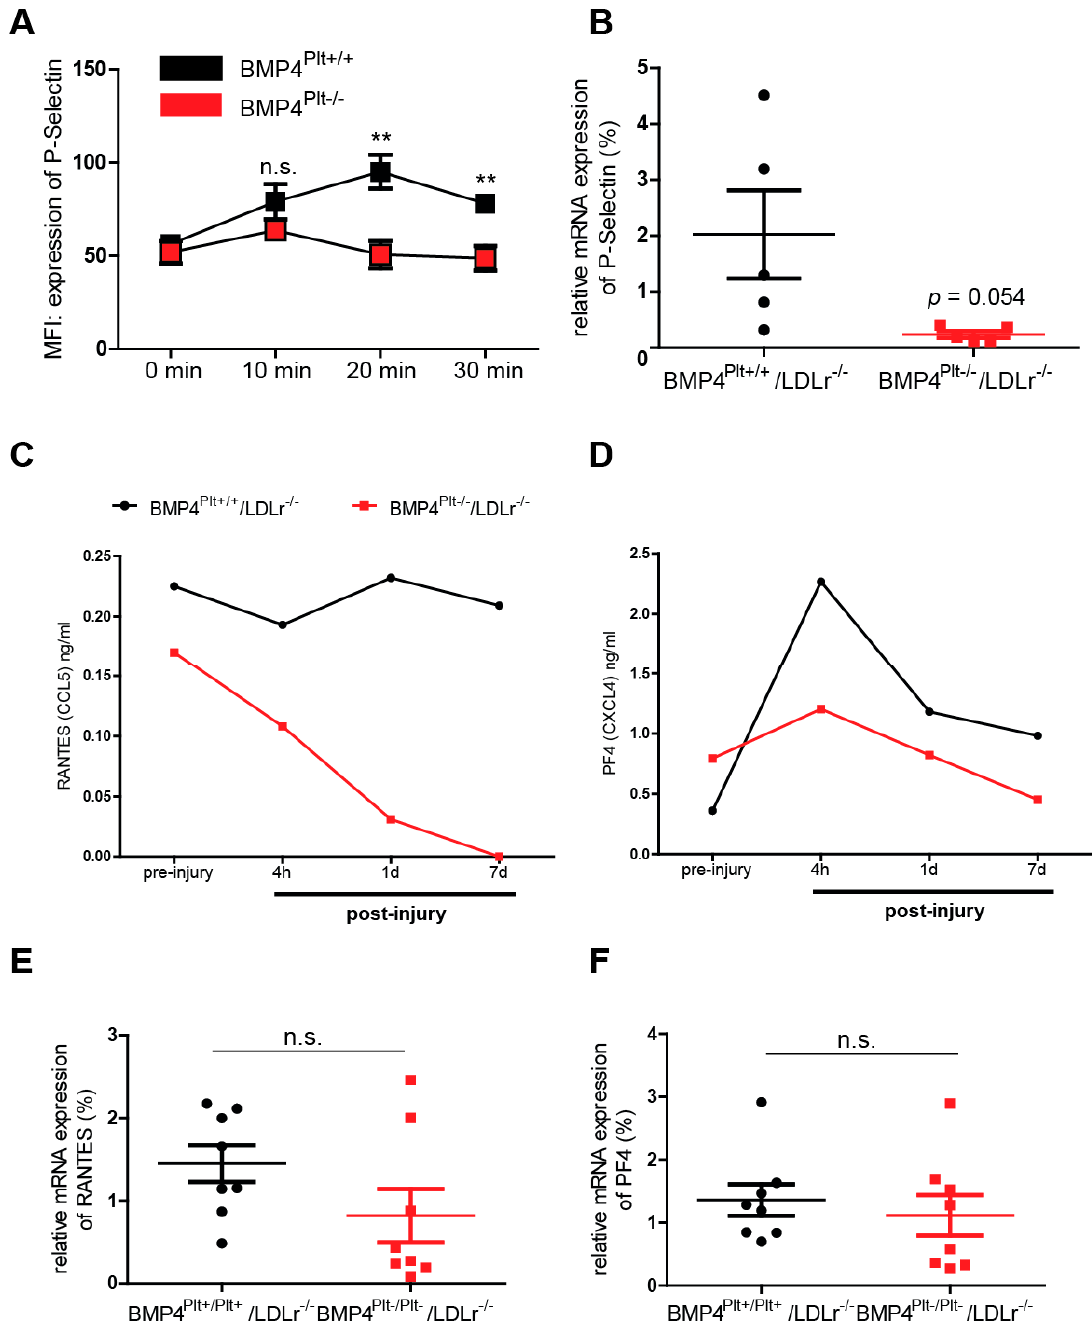
Figure 4. Platelet BMP-4 modulates expression and secretion of P-selectin, RANTES and PF-4. ( A ) Time-dependent release of P-selectin from platelets of control ( BMP4 Plt+/+ ) or BMP4 Plt − / − mice after treatment with TNF α (10 ng/g body weight). n = 5 per group. ( B ) mRNA expression of P-selectin in the carotid artery from control or BMP4 Plt − / − /LDLr − / − mice after guide wire injury. n = 5 per group. ( C , D ) Plasma level of RANTES and PF-4 in control littermates or BMP4 Plt − / − /LDLr − / − mice after carotid wire injury. Plasma from 3 mice were pooled for each group. ( E , F ) mRNA expression of RANTES and PF-4 in the carotid artery of control littermates or BMP4 Plt − / − /LDLr − / − mice seven days after guide wire injury. n = 8 per group. * p ≤ 0.05; ** p ≤ 0.01; n.s., not significant.